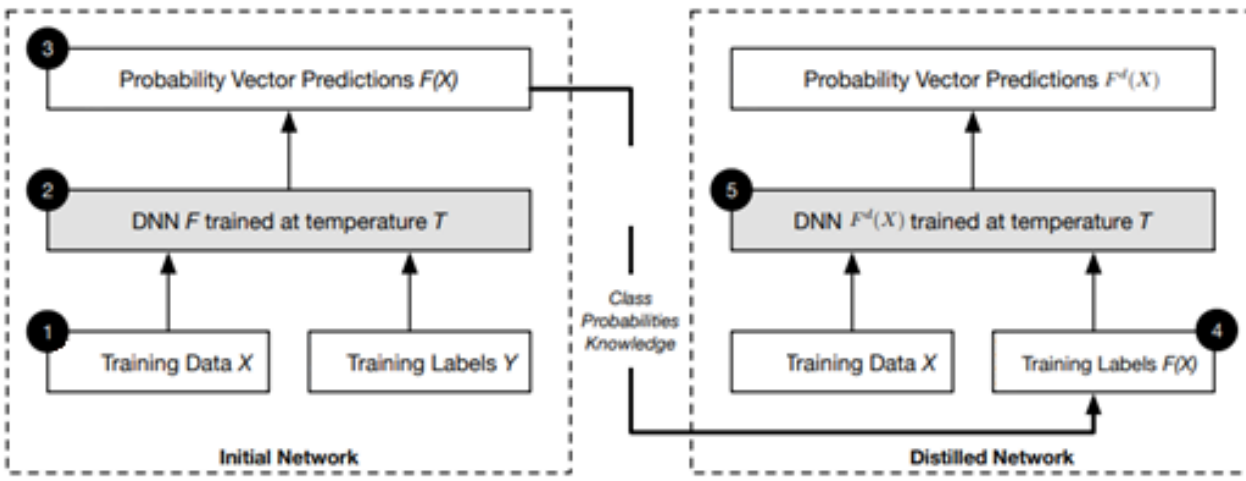
Figure 22. Overview of defense mechanism based on a transfer of knowledge contained in probability vectors through distillation. The main idea behind distillation is that the knowledge acquired by the DNN during training is not only encoded in the weight parameters but also in the probability vectors generated by the network.